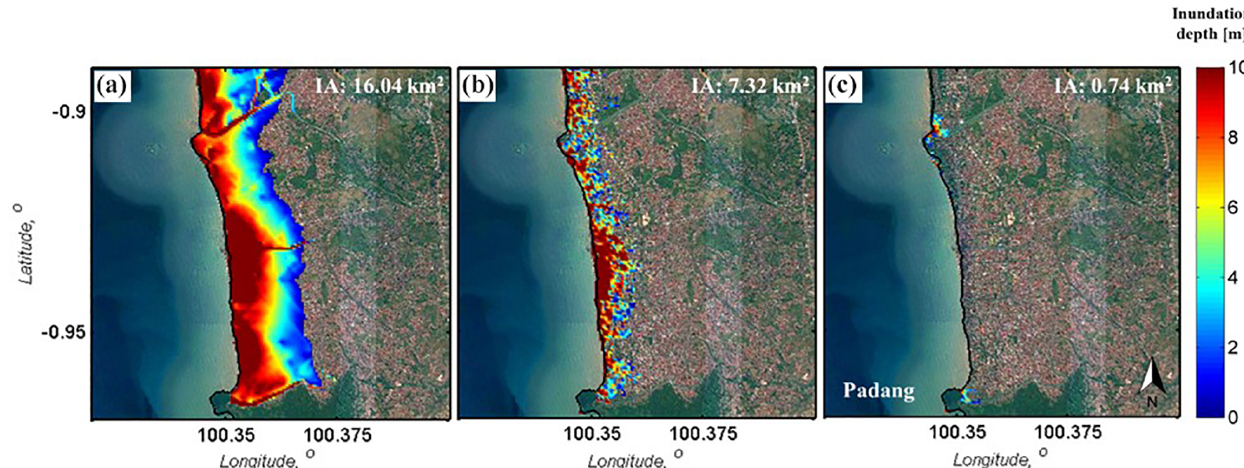
Figure 7. Inundation areas in Padang for (a) DEM5 and (b) SRTM1. (c) GDEM2 (IA is total inundation